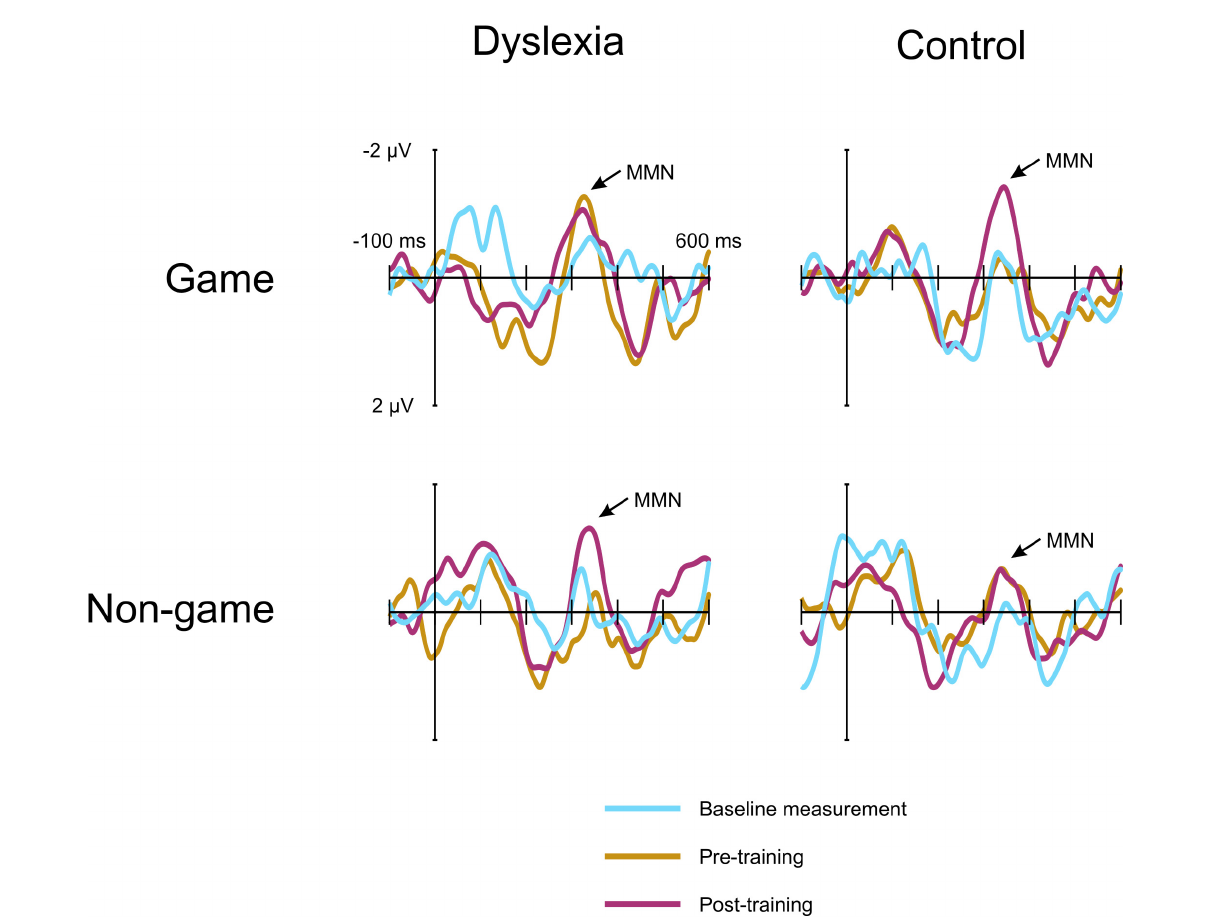
FIGURE5 The MMN responses of the dyslexia group and the control group at electrode FCz. The responses are shown at the baseline measurement, pre-training, and post-training. Negativity is plotted up. The game and the non-game responses are measured from the same children in each group.